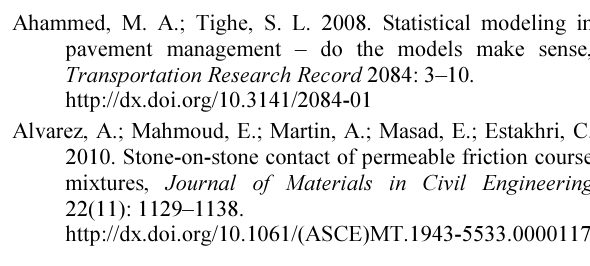
crushed granite, dolomite and